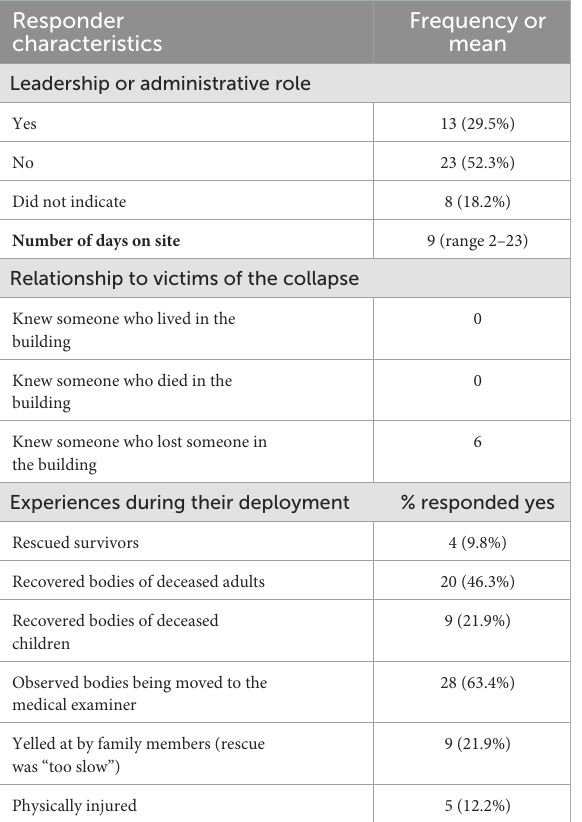
TABLE 2 Responder characteristics. TABLE 3 Means and standard deviations on mental health